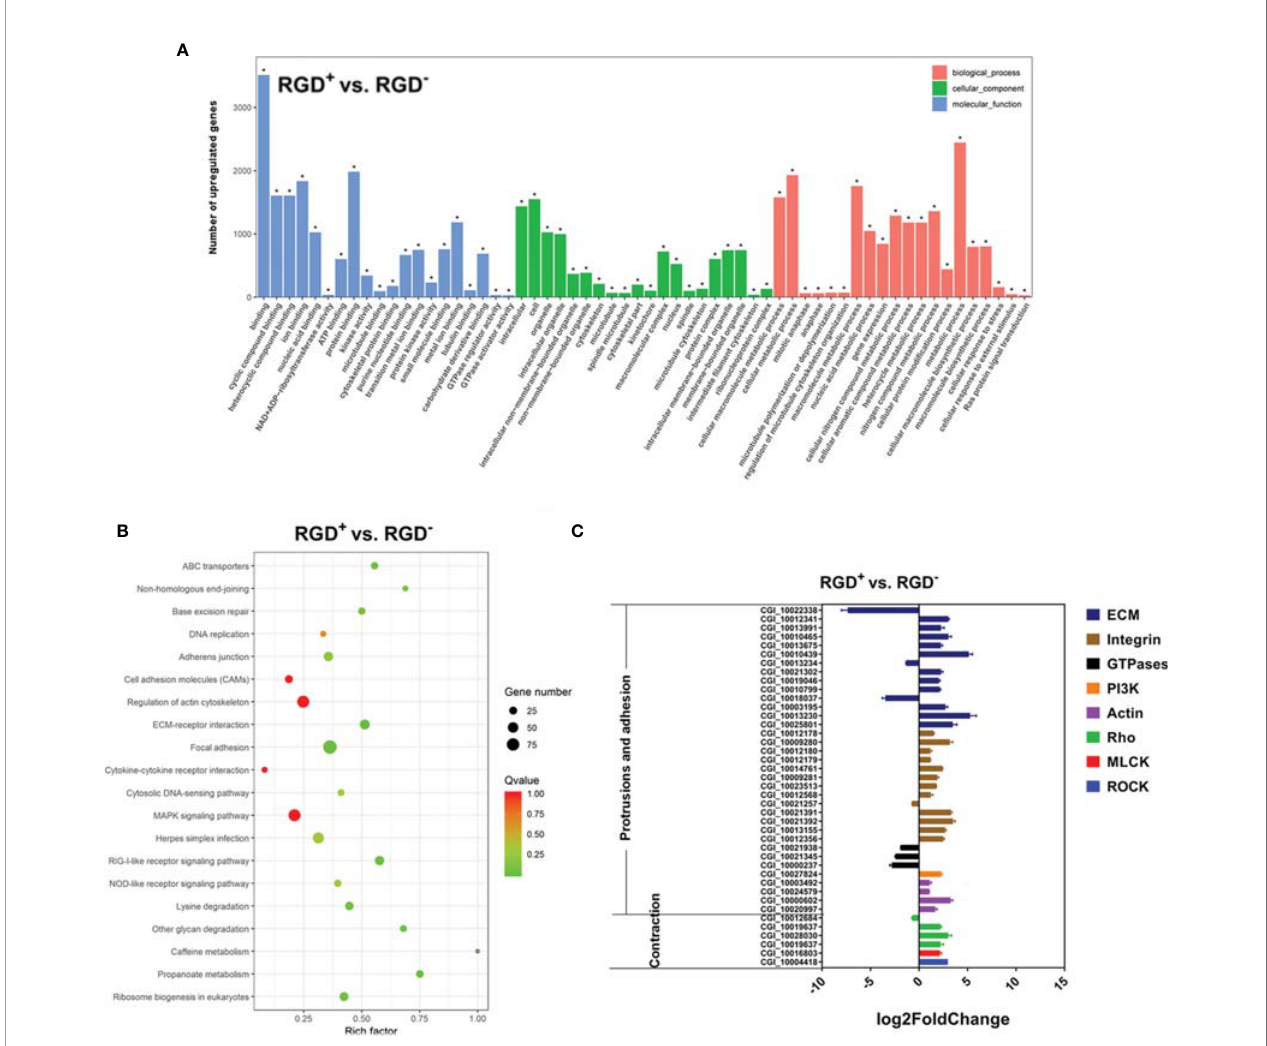
FIGURE 5 | Transcriptome analysis of resting RGD + hemocytes. (A) Top 60 GO terms enriched in the signi fi cantly upregulated genes in the resting RGD + hemocytes compared to the resting RGD - hemocytes. (B) Top 20 KEGG pathway items enriched in the signi fi cantly upregulated genes in the resting RGD + hemocytes compared to the resting RGD - hemocytes. (C) qPCR validation of the 40 selected DEGs involved in the formation of protrusions and fi rm adhesions at the front and contractions at the rear in resting RGD + hemocytes compared to resting RGD - hemocytes. RGD + and RGD - represent the resting RGD + and RGD - hemocytes, respectively. The asterisk (*) stands for statistical signi fi cance at p <